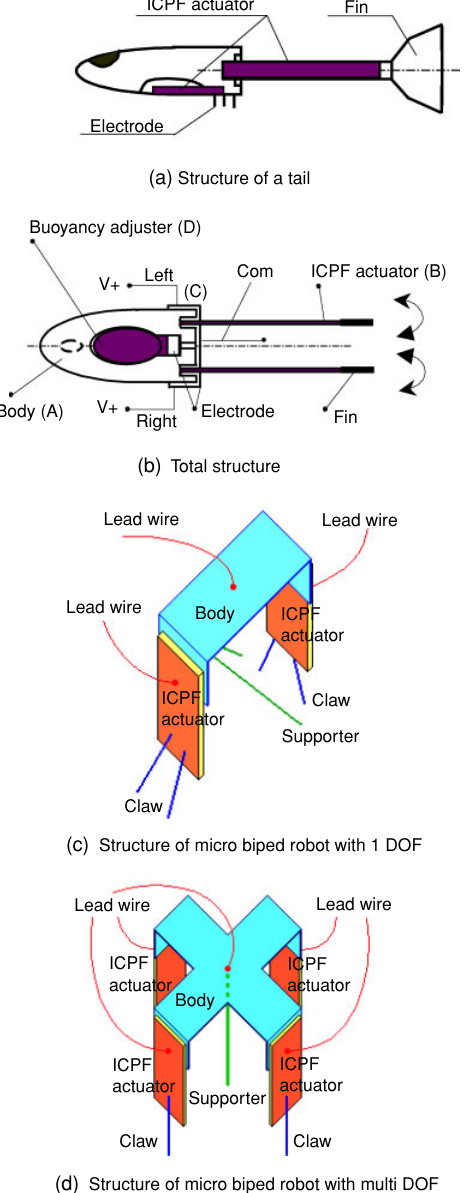
Figure 1 Structure of the micro-robot. (a) Structure of a tail, (b) total structure, (c) structure of micro biped robot with one degree of freedom, (d) structure of micro biped robot with multiple degrees of freedom.